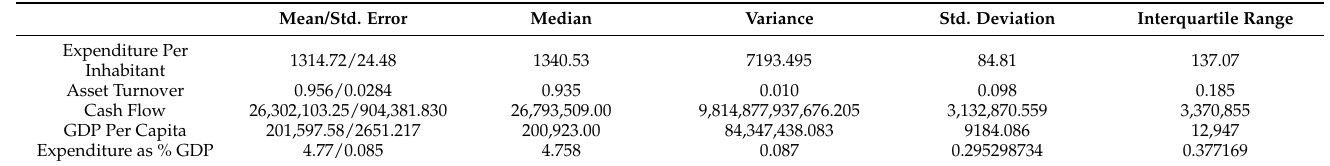
Table 3. Descriptive statistics model for regions with management by agreement.